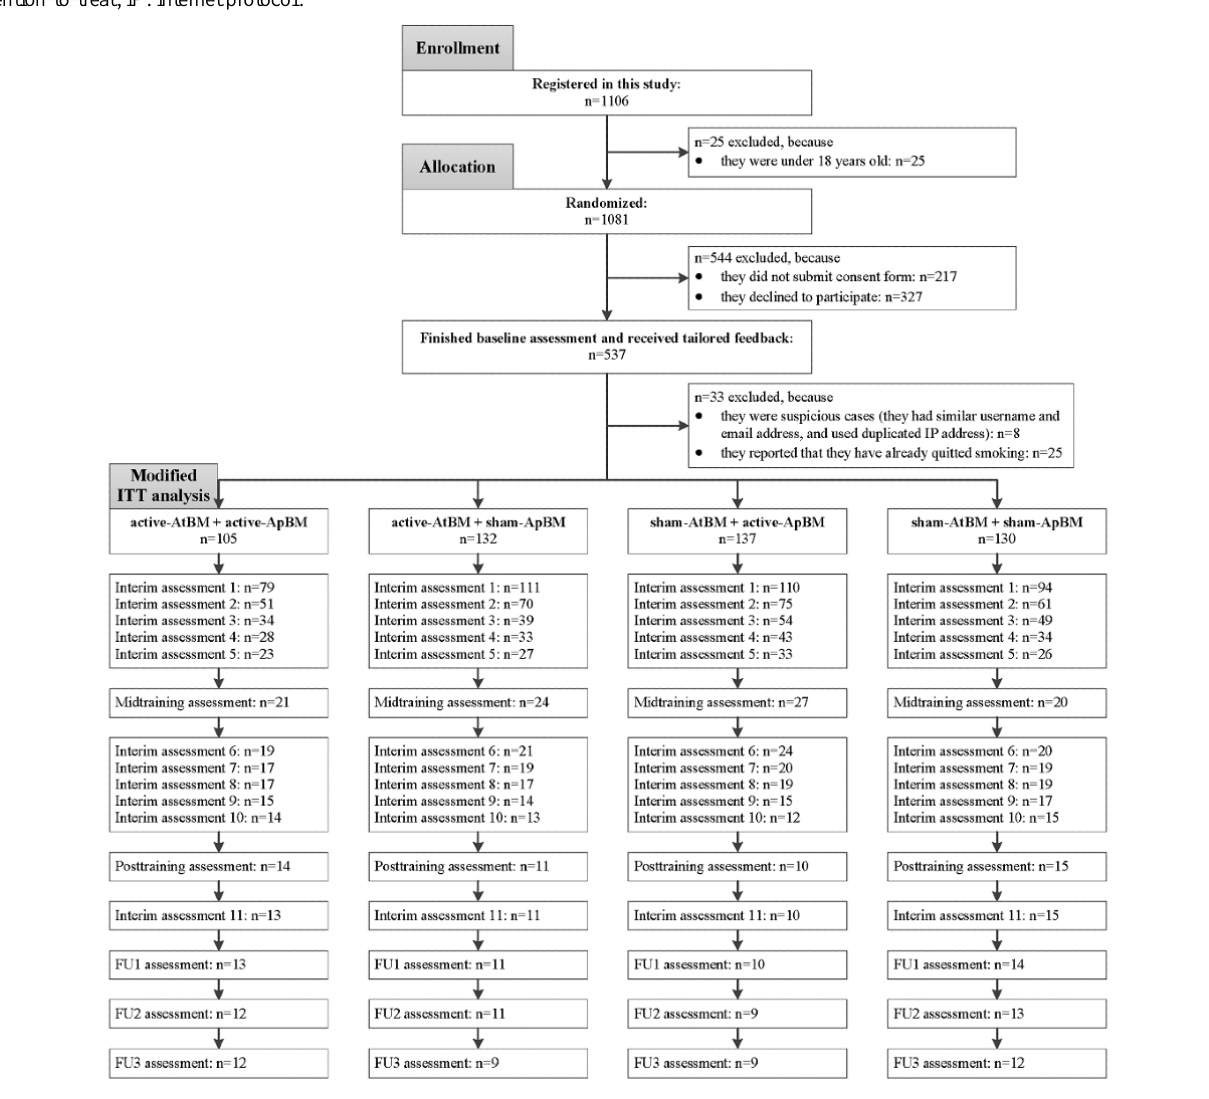
Figure 1. Consolidated Standards of Reporting Trials flow diagram. The number of participants reported here is based on timeline follow back data for our primary outcome. A similar dropout pattern is observed for all other outcomes. AtBM: attentional bias modification; ApBM: approach bias modification; Interim assessment: brief assessment before each training session; FU1, FU2, FU3: follow-up assessment at 1, 2, and 3 months; ITT: intention-to-treat; IP: internet